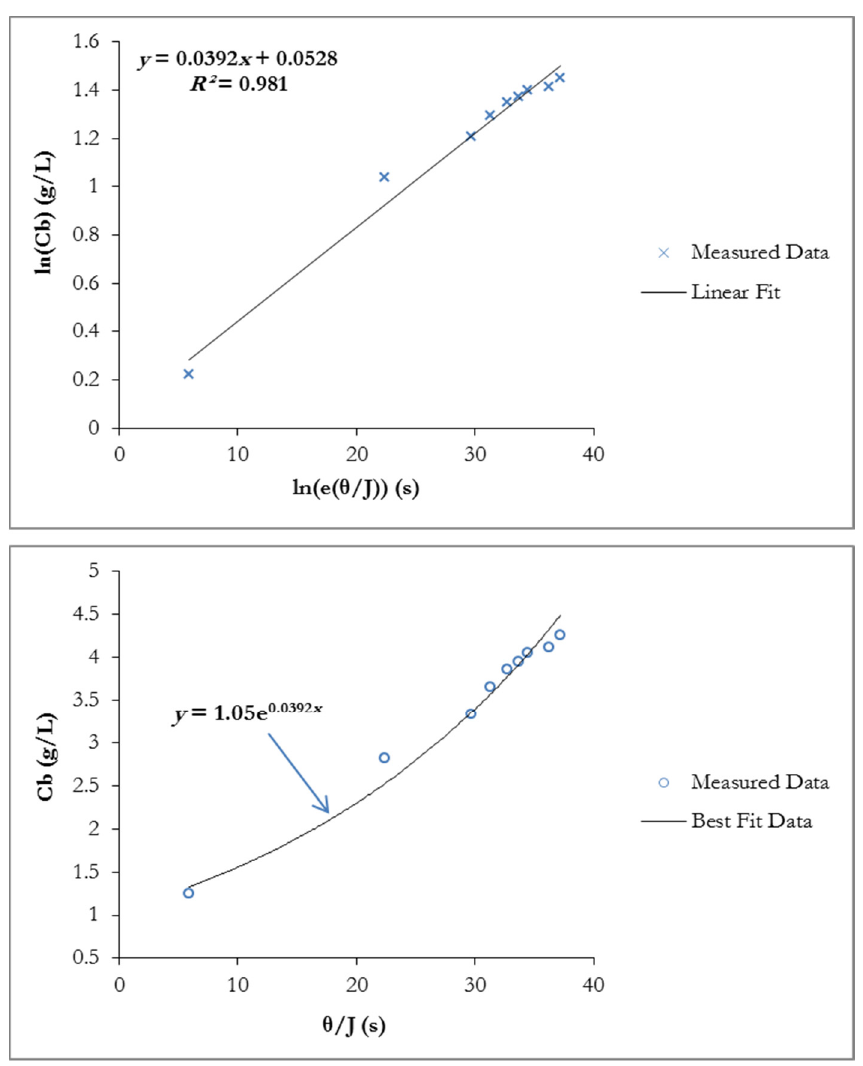
Figure 9. Mixed liquor suspended solids (MLSS) concentration plotted against cake thickness ratio for rotating MBR